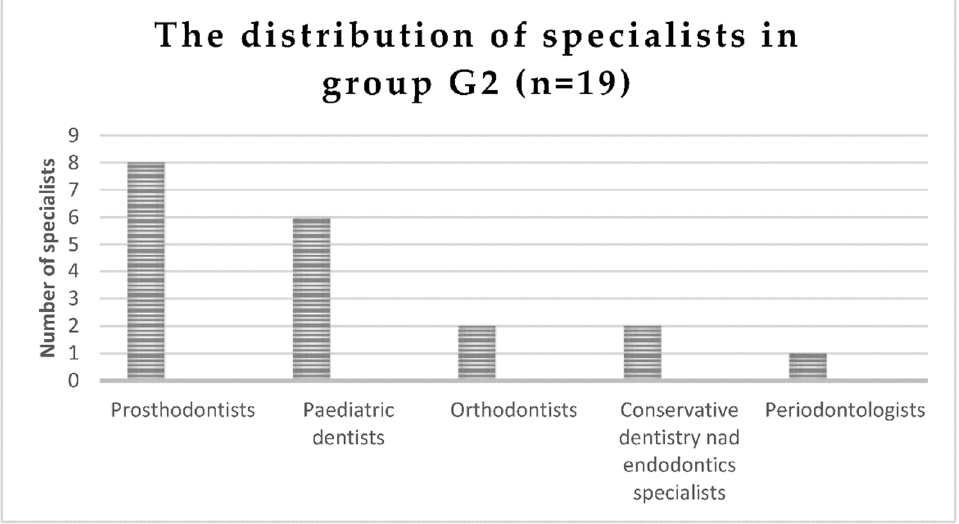
Figure 2. The number of the specialists in fields other than dental surgery and maxillofacial surgery (group G2) .